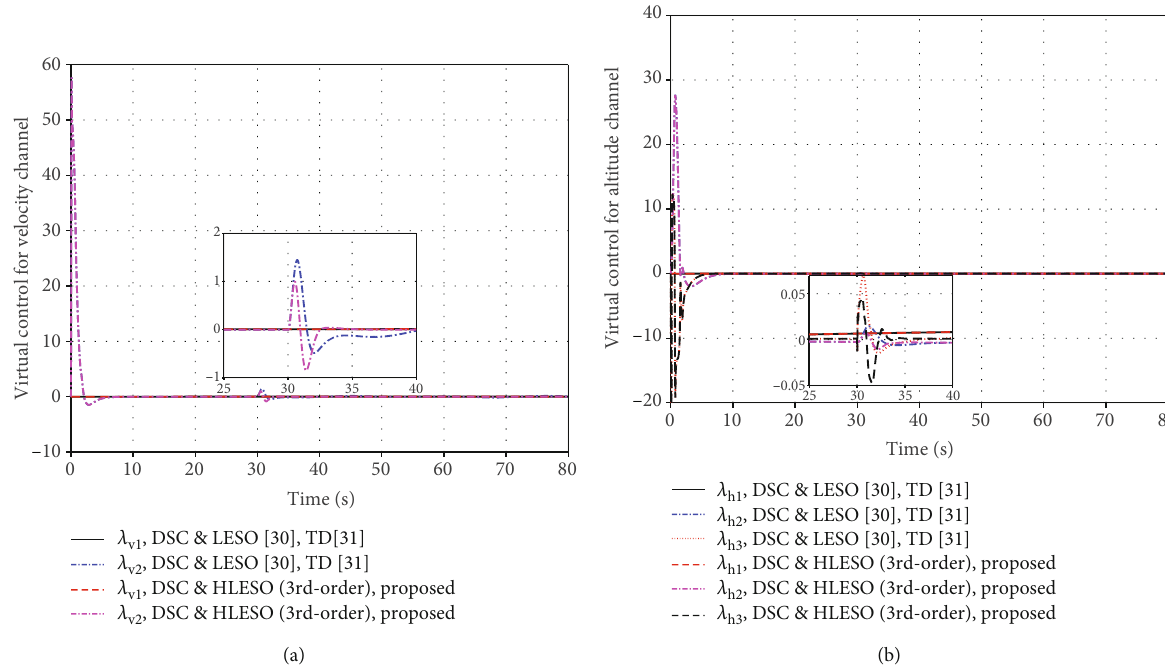
Figure 4: The virtual control signals: (a) velocity channel λ